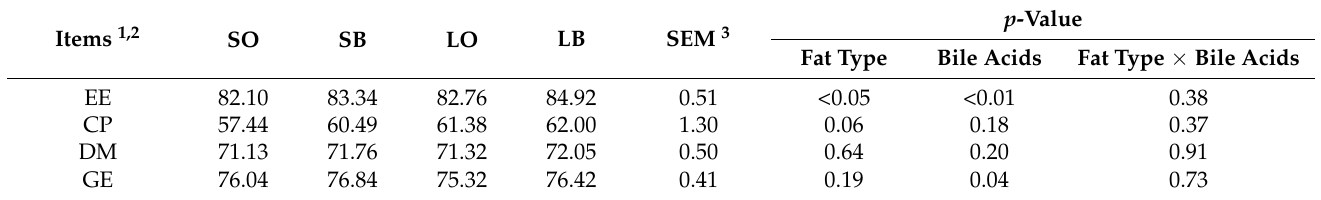
Table 5. Effects of bile acids supplemented in diet included with different types of fat on dietary nutrient digestibility in broiler chickens (%).